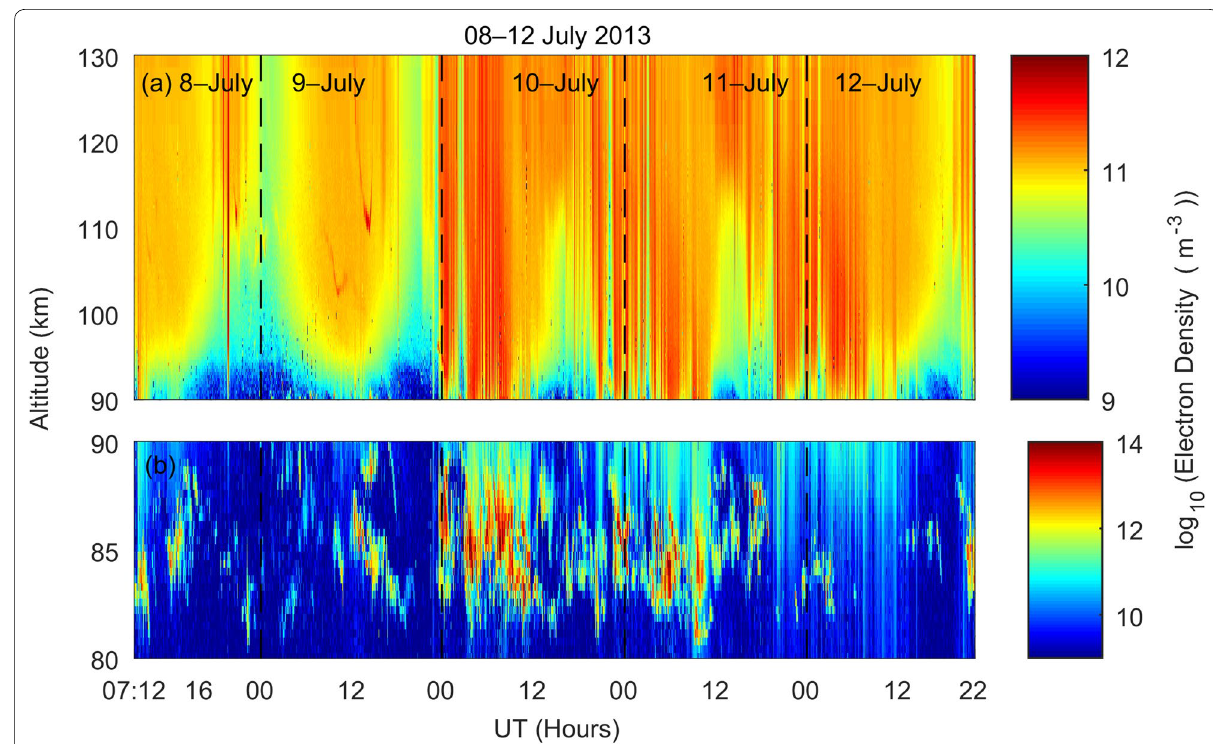
Fig. 1 Calibrated electron densities for particle precipitation ( a ) and for a highly dynamic PMSE during particle precipitation ( b